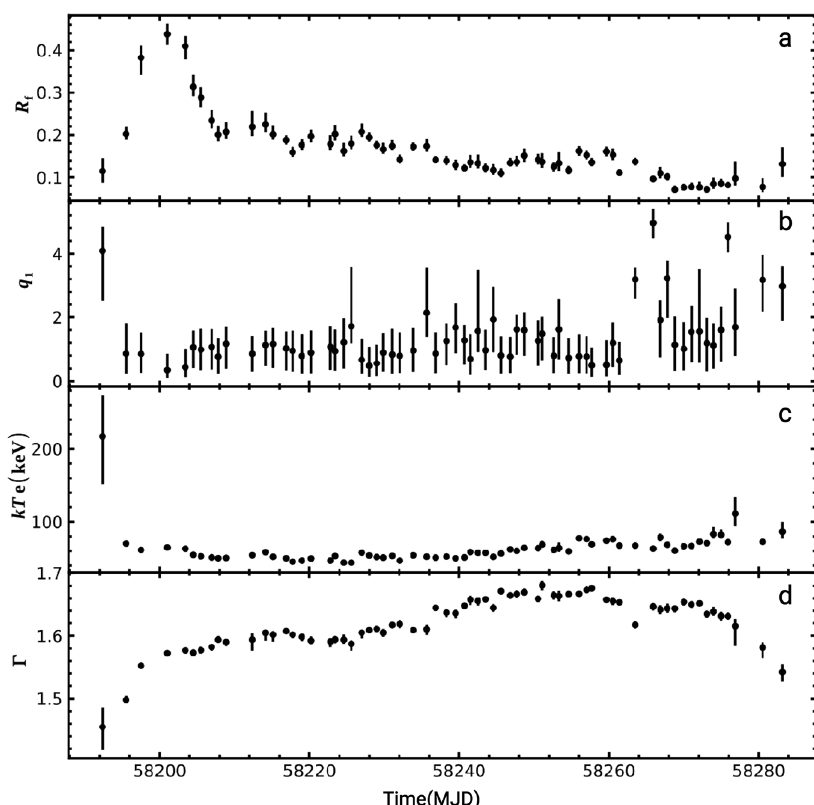
Fig. 3 Time-evolutions of the free parameters in the best- fi tting of the spectral model (1). The evolution of the dimensionless re fl ection fraction R f which is de fi ned as the ratio of intensity emitted towards the disk to that emitted to in fi nity, the dimensionless index q 1 of the emissivity pro fi le, the electron temperature T e in units of keV, and the incident photon index Γ , are plotted in subpanels ( a ), ( b ), ( c ), and ( d ), respectively. Assuming an inclination angle θ = 63 ∘ , the inner/outer radius of the re fl ection disk R in = R ISCO ( R ISCO is innermost stable circular orbit) and R out = 1000 R g , the black hole spin a = 0.998. The black points correspond to the median of the values and the error bars correspond to 68% con fi dence interval, which is calculated using the corner 59 package to analyse the probability distributions derived from the MCMC chains. The uncertainties of the fi tted parameters arise from both the statistical and systematic uncertainties.